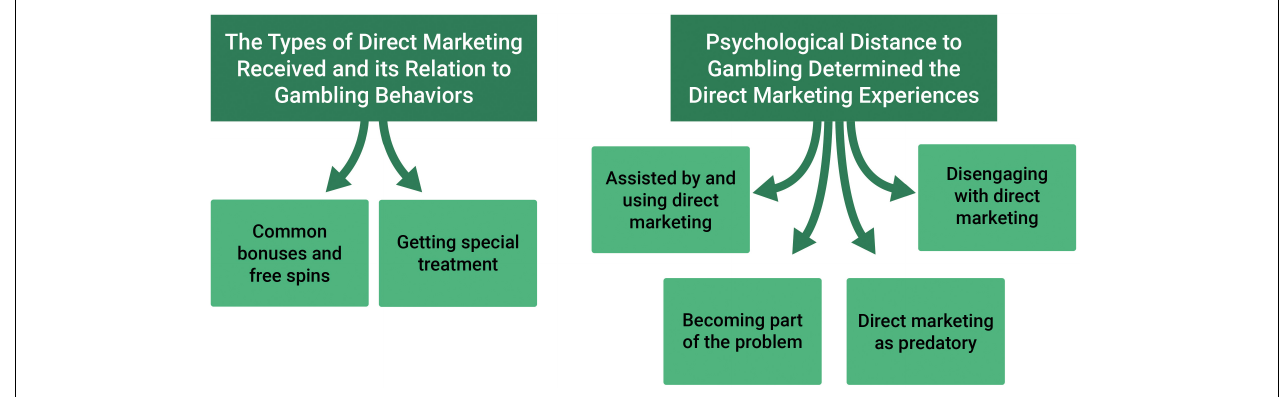
FIGURE 1 | A thematic map illustrating two overarching themes with two and four subthemes, respectively, that captures participants’ experiences with gambling-related direct marketing.